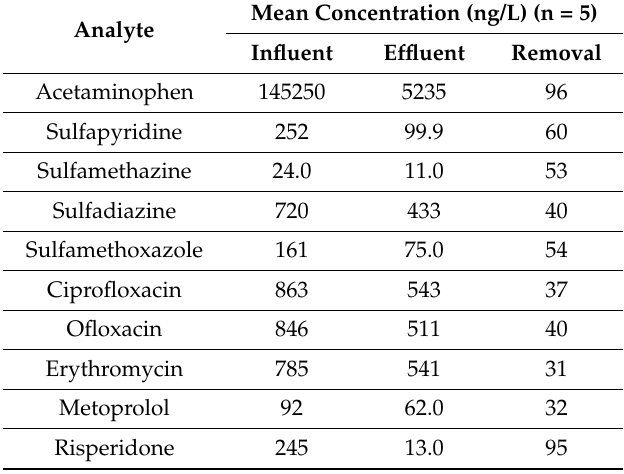
Table 6. Concentrations of target contaminants in influent and effluent wastewaters of Sharjah STP and their removal